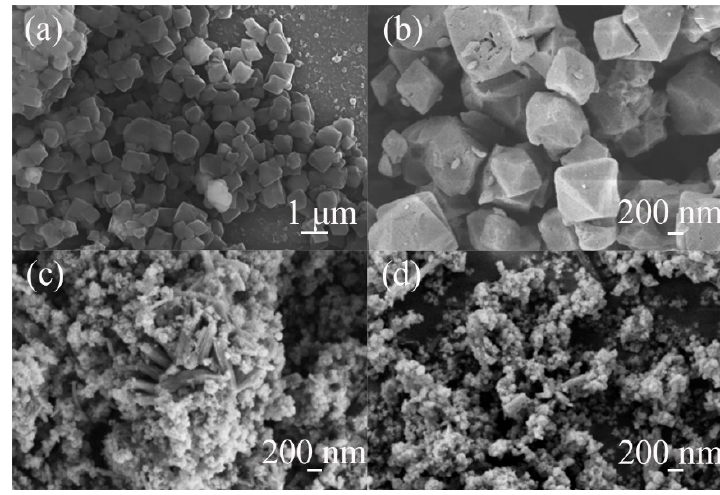
Figure 2. SEM images of: ( a ) MA , ( b ) MAS , ( c ) MC , and ( d ) MCS.